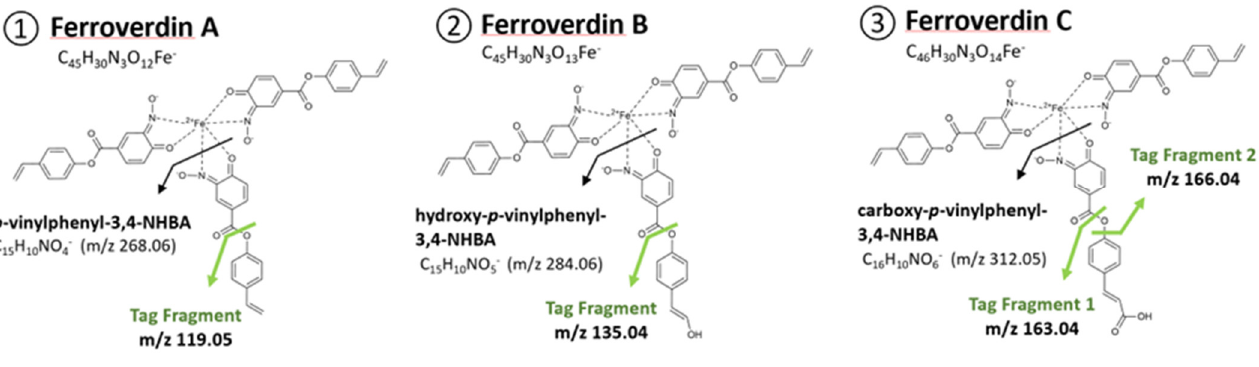
Figure 1. Molecular tag signals for the identification of ferroverdin-related compounds. ① For ferroverdin A, B, and C, the m / z ratios are 268.06 and 119.05 (for the p- vinylphenyl-3,4-NHBA and its major MS fragment); ② For ferroverdin B, the m / z ratios are 284.06 and 135.04 (for the hydroxy- p -vinylphenyl-3,4-NHBA and its major MS fragment); ③ For ferroverdin C, the m / z ratios are 312.05, 163.04, and 166.04 (for carboxy- p -vinylphenyl-3,4-NHBA and its two major MS fragments).